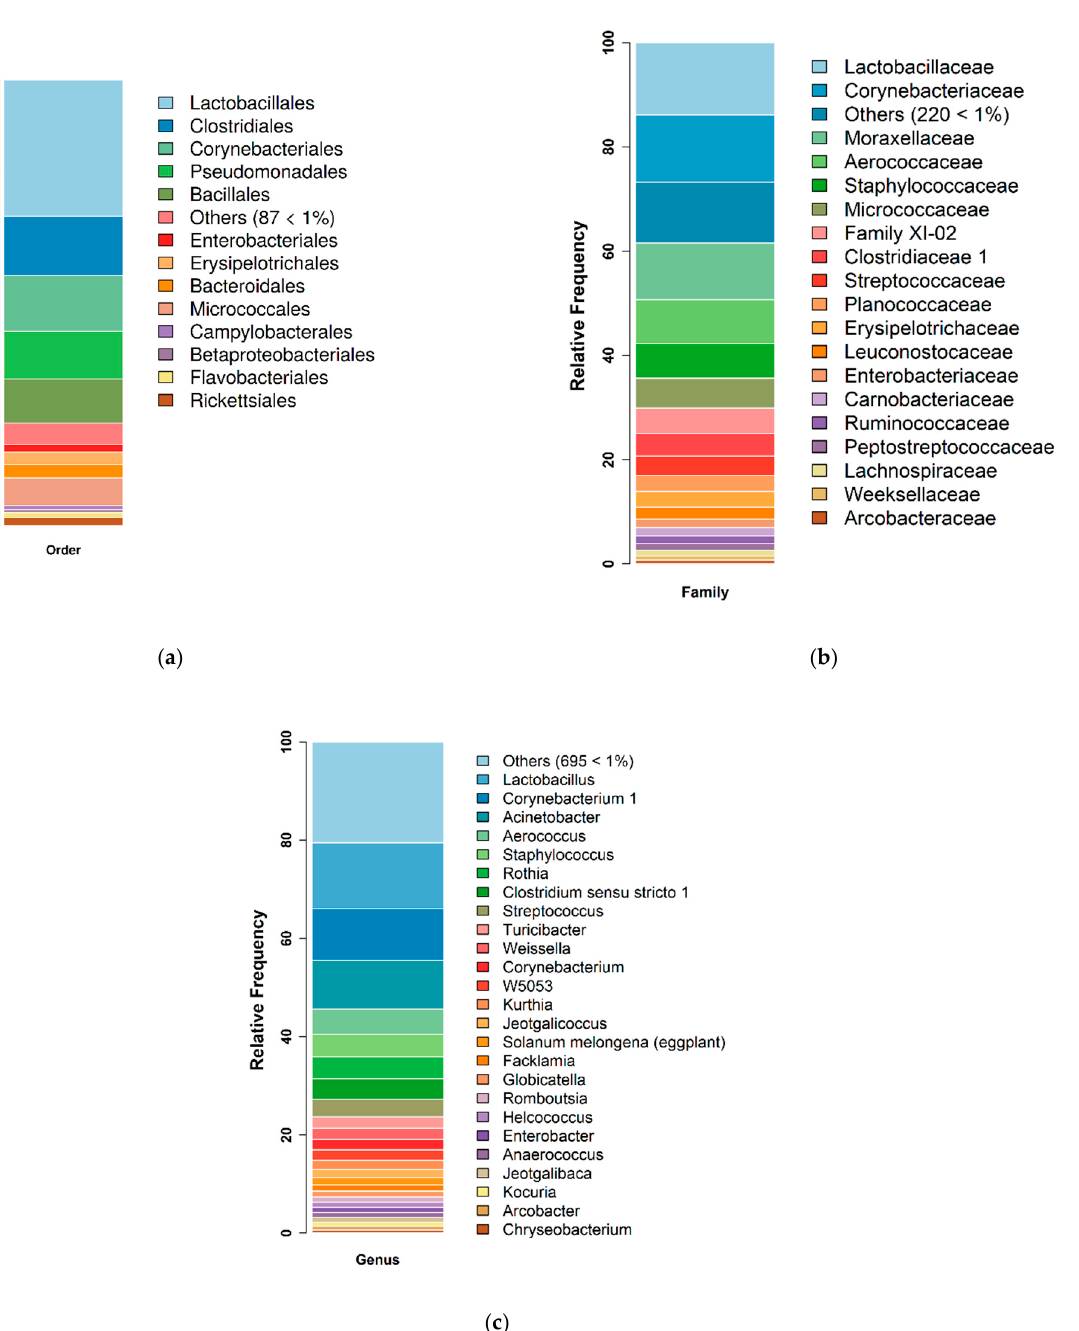
Figure 1. Bacterial microbiota structure of the oral fluid in sows (n=22). ( a ) Bacterial microbiota structure at the order level of the oral fluid in sows ( n = 22). Only the bacterial orders that shared >1% abundance are indicated by different colors, while the others were grouped together. ( b ) Bacterial microbiota structure at the family level of the oral fluid in sows ( n = 22). Only the bacterial families that shared >1% abundance are indicated by different colors, while the others were grouped together. ( c ). Bacterial microbiota structure at the genus level of oral fluid in sows ( n = 22). Only the bacterial genera that shared >1% abundance are indicated by different colors, while the others were grouped together.